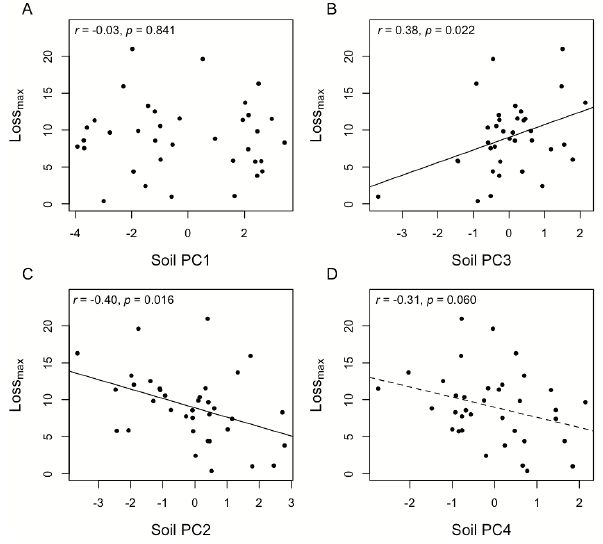
Figure 4. The relationship between the stand-level percent stem biomass lost to stem rot (Loss max ) among trees sampled in a clus- ter and mean values of the first four soil principle component (PC) axes for 36 tree clusters containing at least 10 trees ≥ 30cm DBH. The Pearson correlation coefficient ( r ) and associated probability of each relationship is in its respective